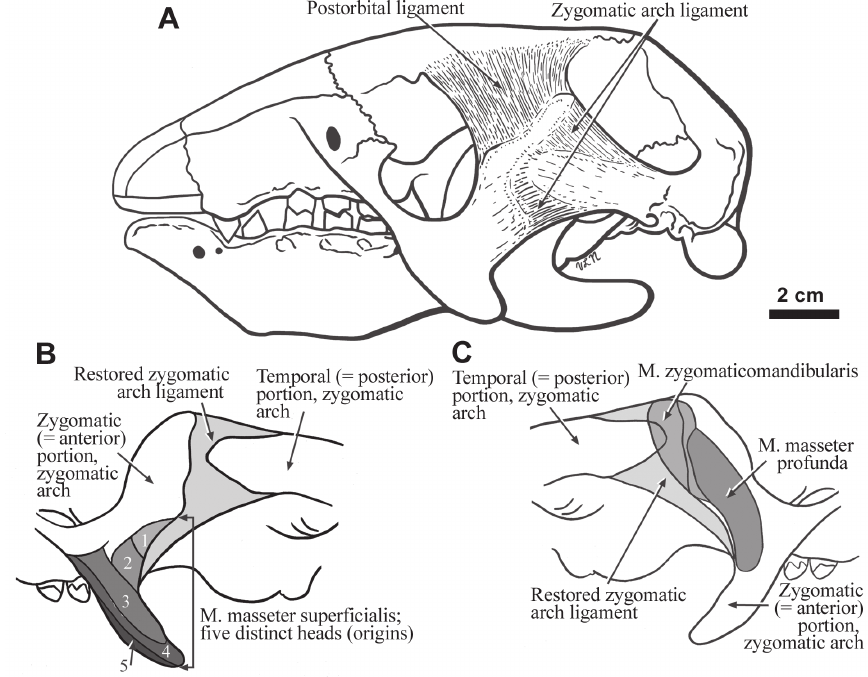
Figure 3. The cranium of Hapalops in lateral view showing the restored cranial ligaments ( A ). Enlargements of the lateral ( B ) and medial ( C ) surfaces of both the anterior and posterior portions of the zygomatic arch in Hapalops are also shown, along with the zygomatic arch ligament, and the locations of the scars of muscle and muscle head origins that are indicated by differentially shaded